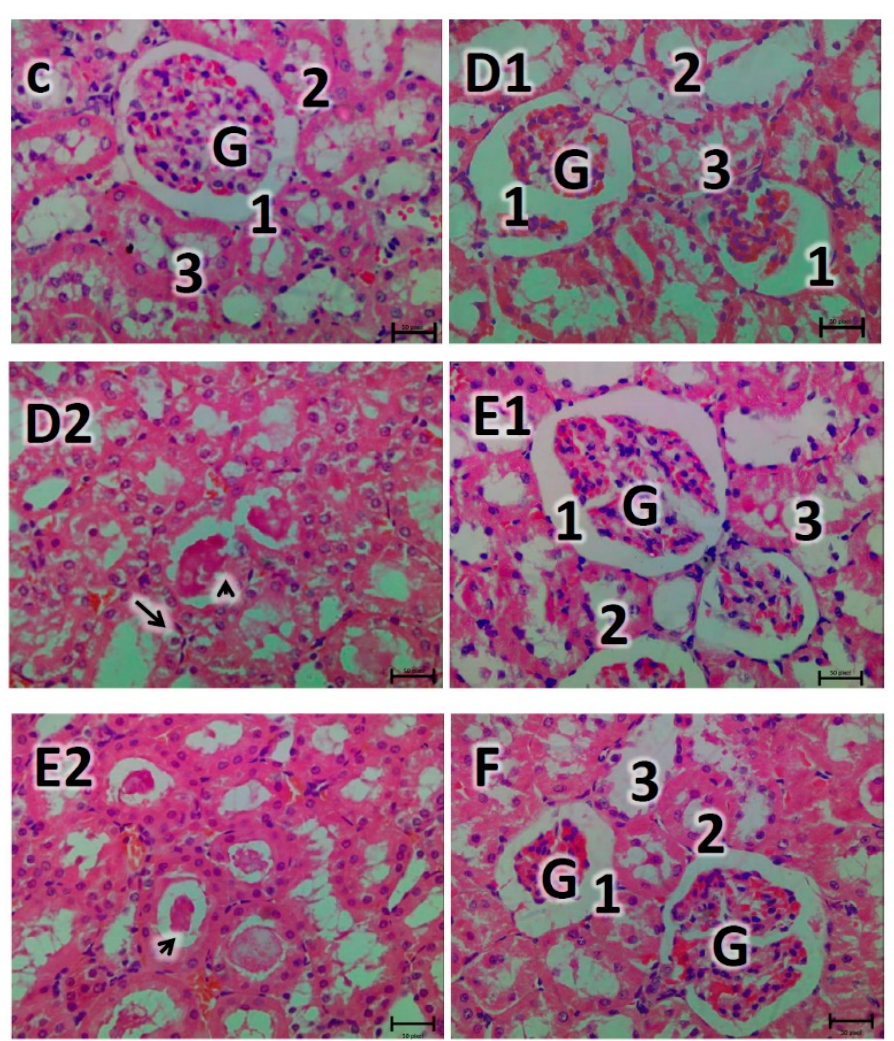
Figure 5. Haematoxylin and eosin stained kidney parenchyma photo micrographs. ( A ) represents: normal control kidney showing the renal cortex with normal glomerulus (G) surrounded by capsule with normal capsular space (1) and normal tubular system distal convoluted tubules (DCT) (2) and normal proximal convoluted tubules (PCT) (3). ( B ) and ( C ) represent photo micrographs of normal rats treated with vindoline and glibenclamide respectively showing normal renal parenchyma. ( D1 ) represents the diabetic control kidney section showing shrunken glomeruli ( G ) with distorted capillaries surrounded by excessive widened Bowman’s space (1), the PCT cells appear to be vacuolated cytoplasm (3). Figure ( D2 ) indicates cortical tubules with acidophilic hyaline casts (arrow head). Figure ( E1 ) represents the diabetic group treated with vindoline showing glomeruli that are surrounded by narrower Bowman’s space (1), hyaline casts (arrow heads) shown in Figure ( E2 ). Figure ( F ) represents the diabetic group treated with glibenclamide showing restored glomerulus (G) with prominent glomerular capillaries, capsular space looks narrow (1).